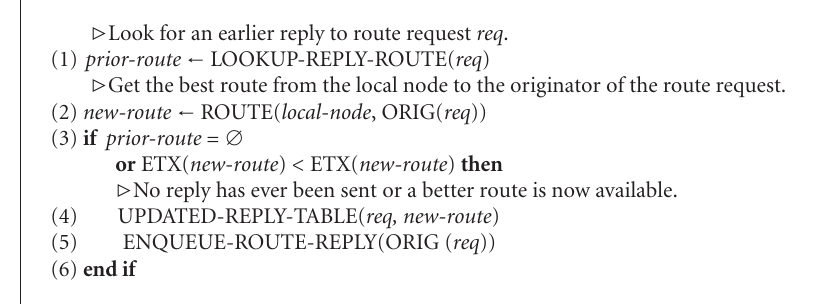
Algorithm 4: The route-reply